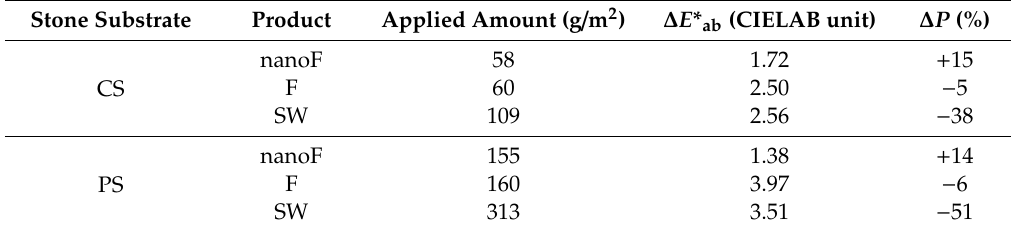
Table 1. Amount of applied product, color change ( ∆ E * ab ) and variation of water vapor permeability ( ∆ P ) evaluated after the protective treatment [47].